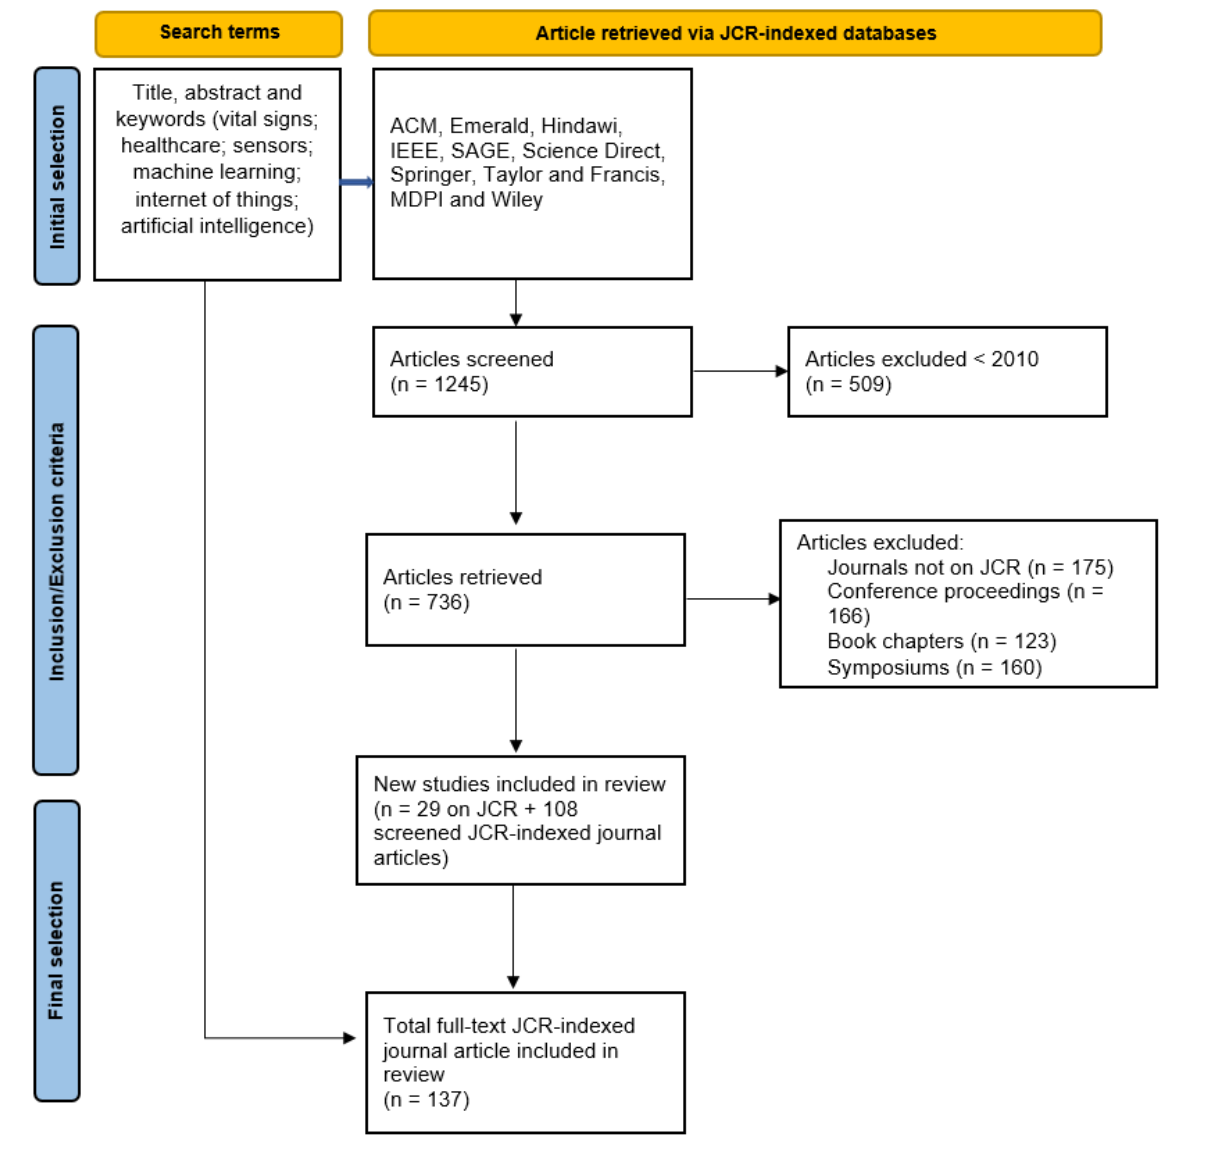
Figure 1. Article selection process.